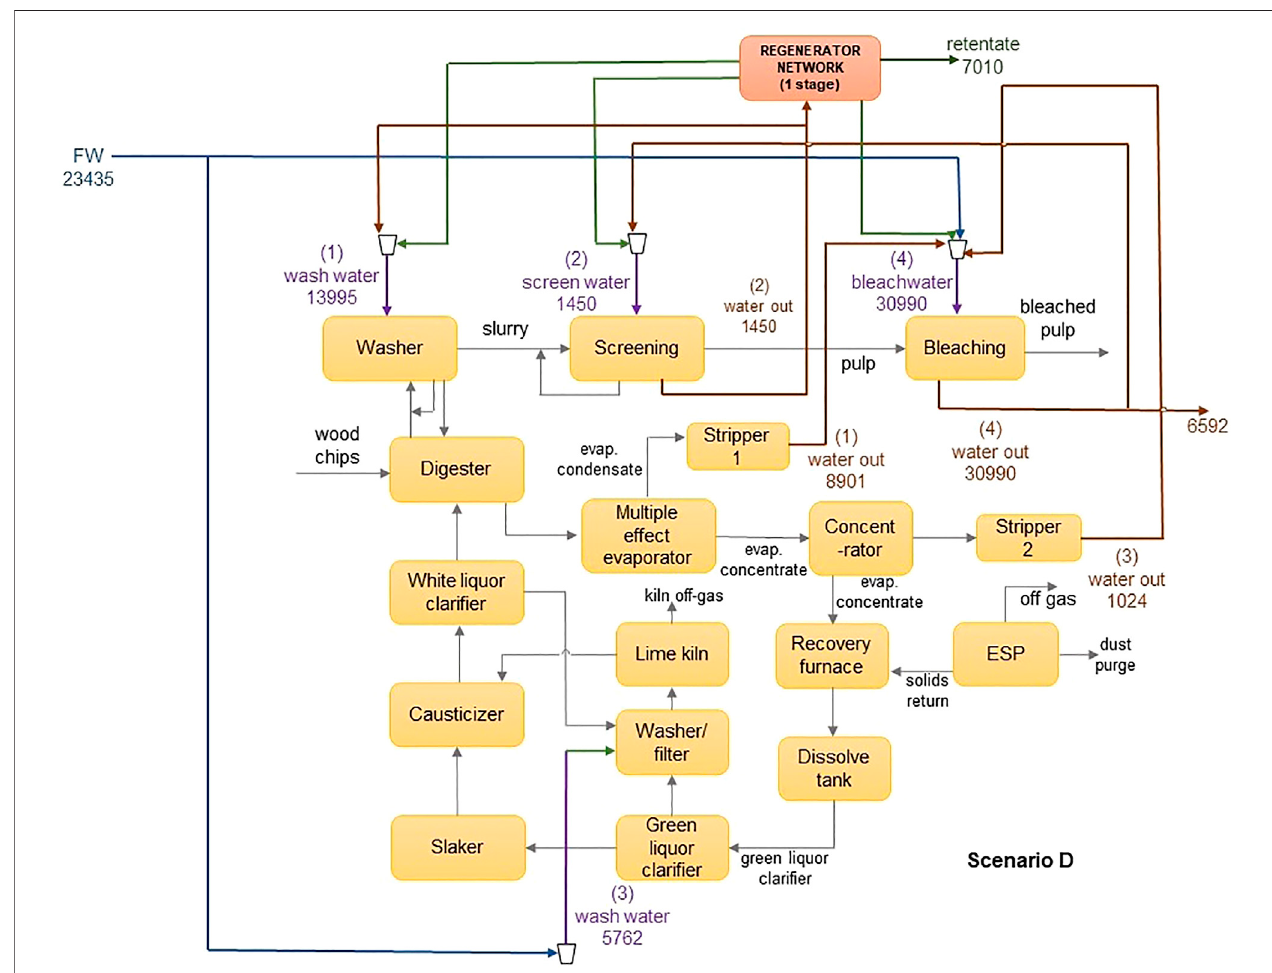
FIGURE 6 | Optimal fl owsheet for scenario D (detailed regenerator model with customized modules).